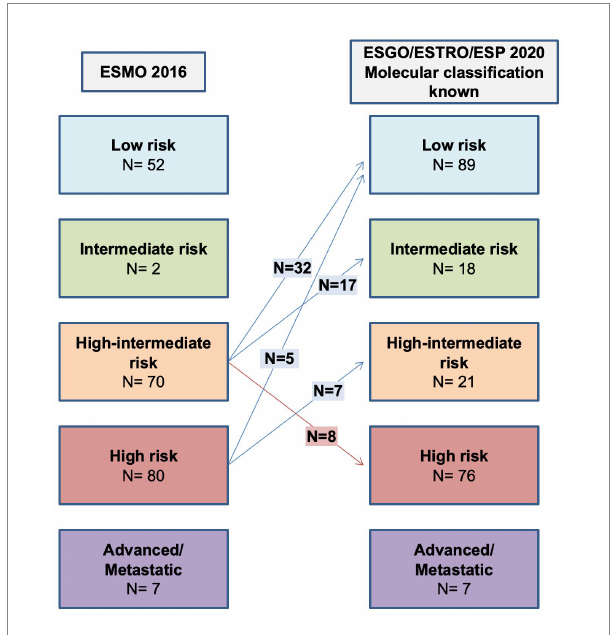
FIGURE 2 Comparison between ESMO 2016 recommendations and ESGO/ ESTRO/ESP 2020 guidelines with molecular classification known.